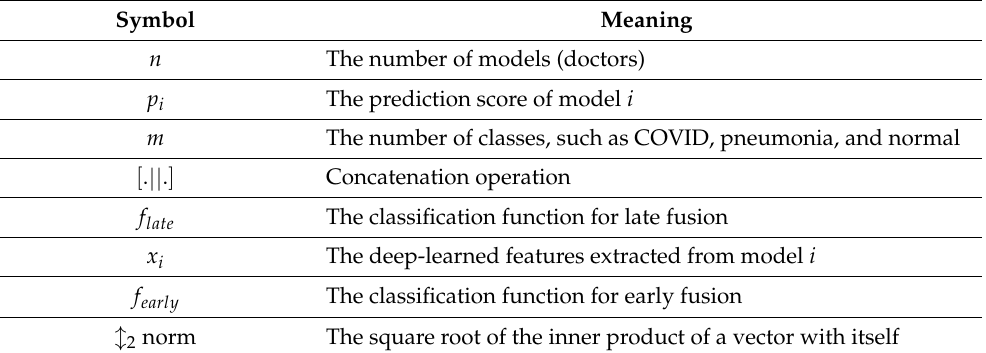
Table 3. Table of symbols used in this